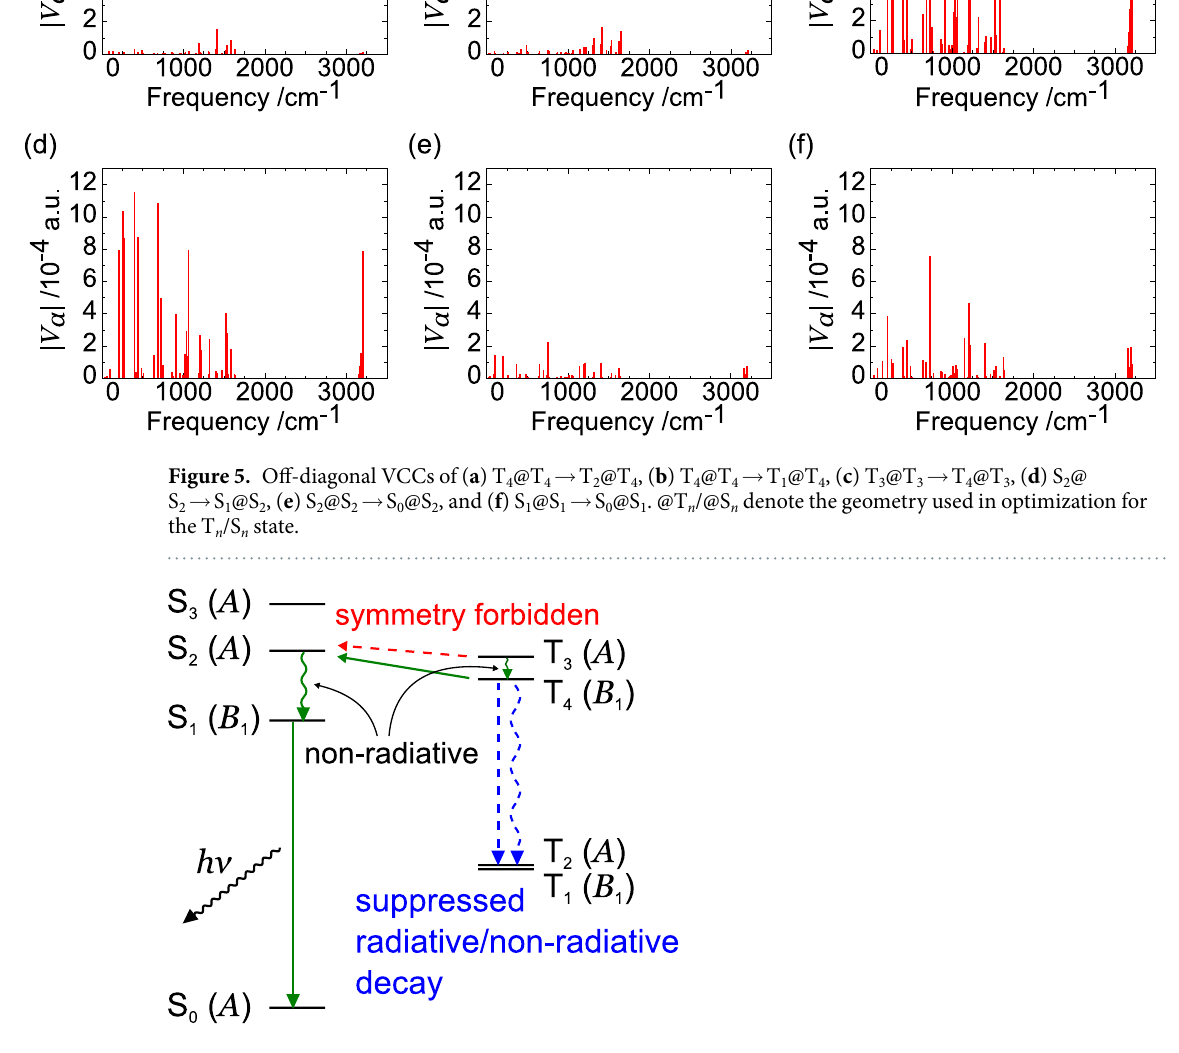
Figure 6. Scheme of the excited state dynamics in BD1. Horizontal solid arrows indicate RISC, vertical straight arrows indicate radiative transitions, and wavy arrows denote non-radiative